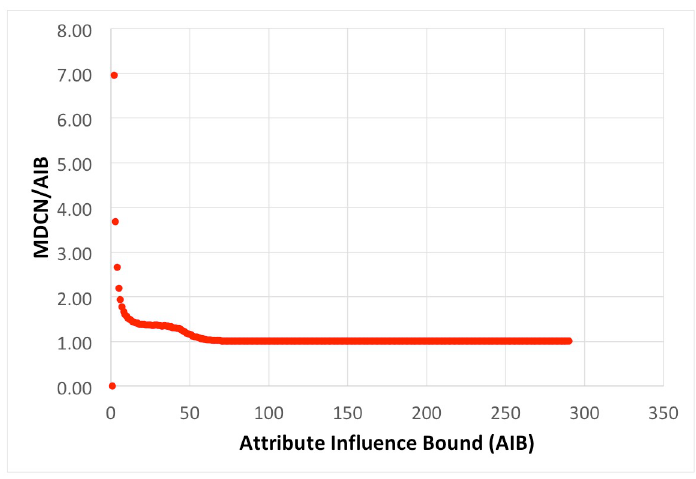
Fig 17. The ratio MDCN/AIB = Mean Distance to Closest Neighbor/AIB as a function of AIB, standard conditions.